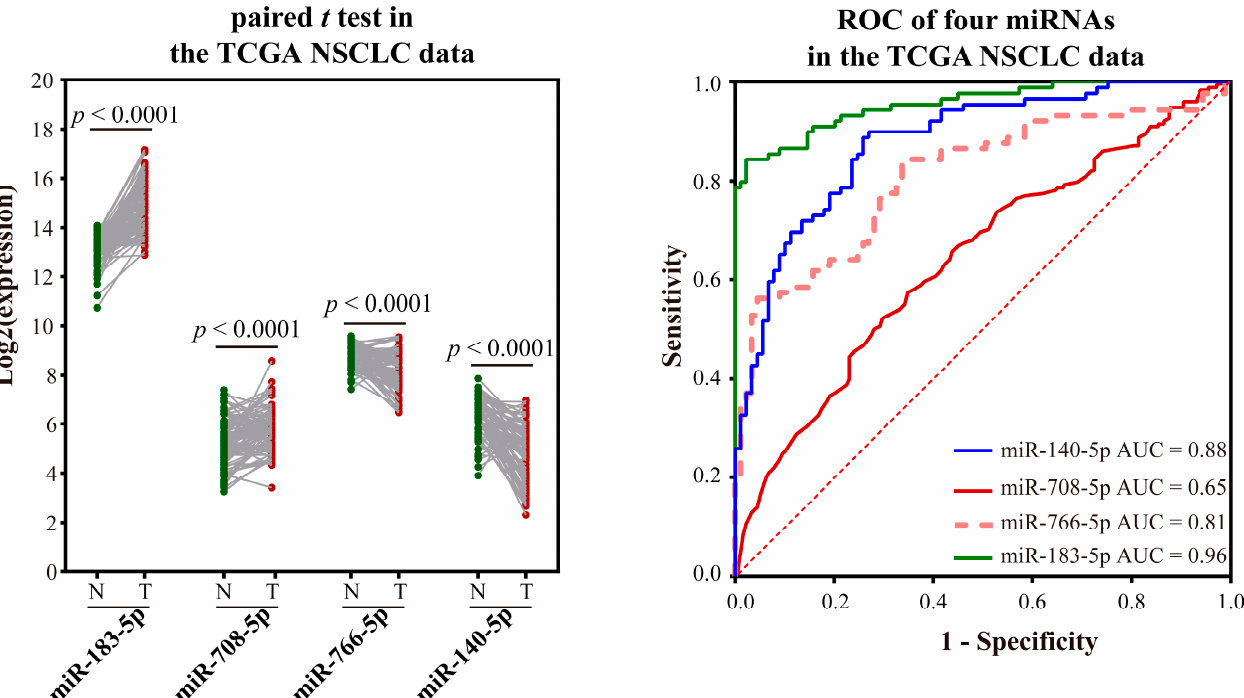
Figure 8. Validation of miRNA markers in paired NSCLC and normal samples in TCGA. The green dot indicates the normal sample, while the red dot indicates the tumor sample, and the line indicates the paired samples.